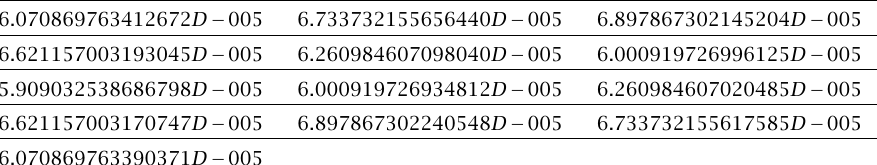
Table 3.8 . The errors with n = 13 , l = 0 . 5 on γ 0